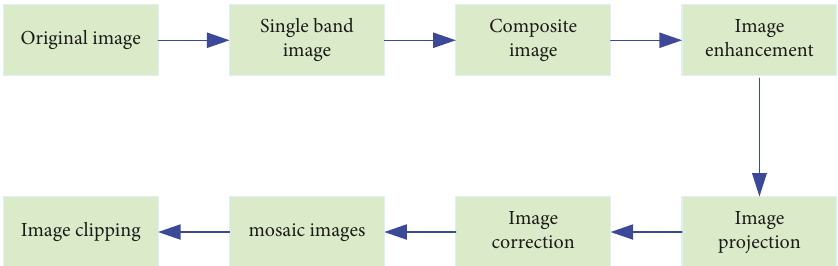
Figure 1: Schematic diagram of remote sensing image processing